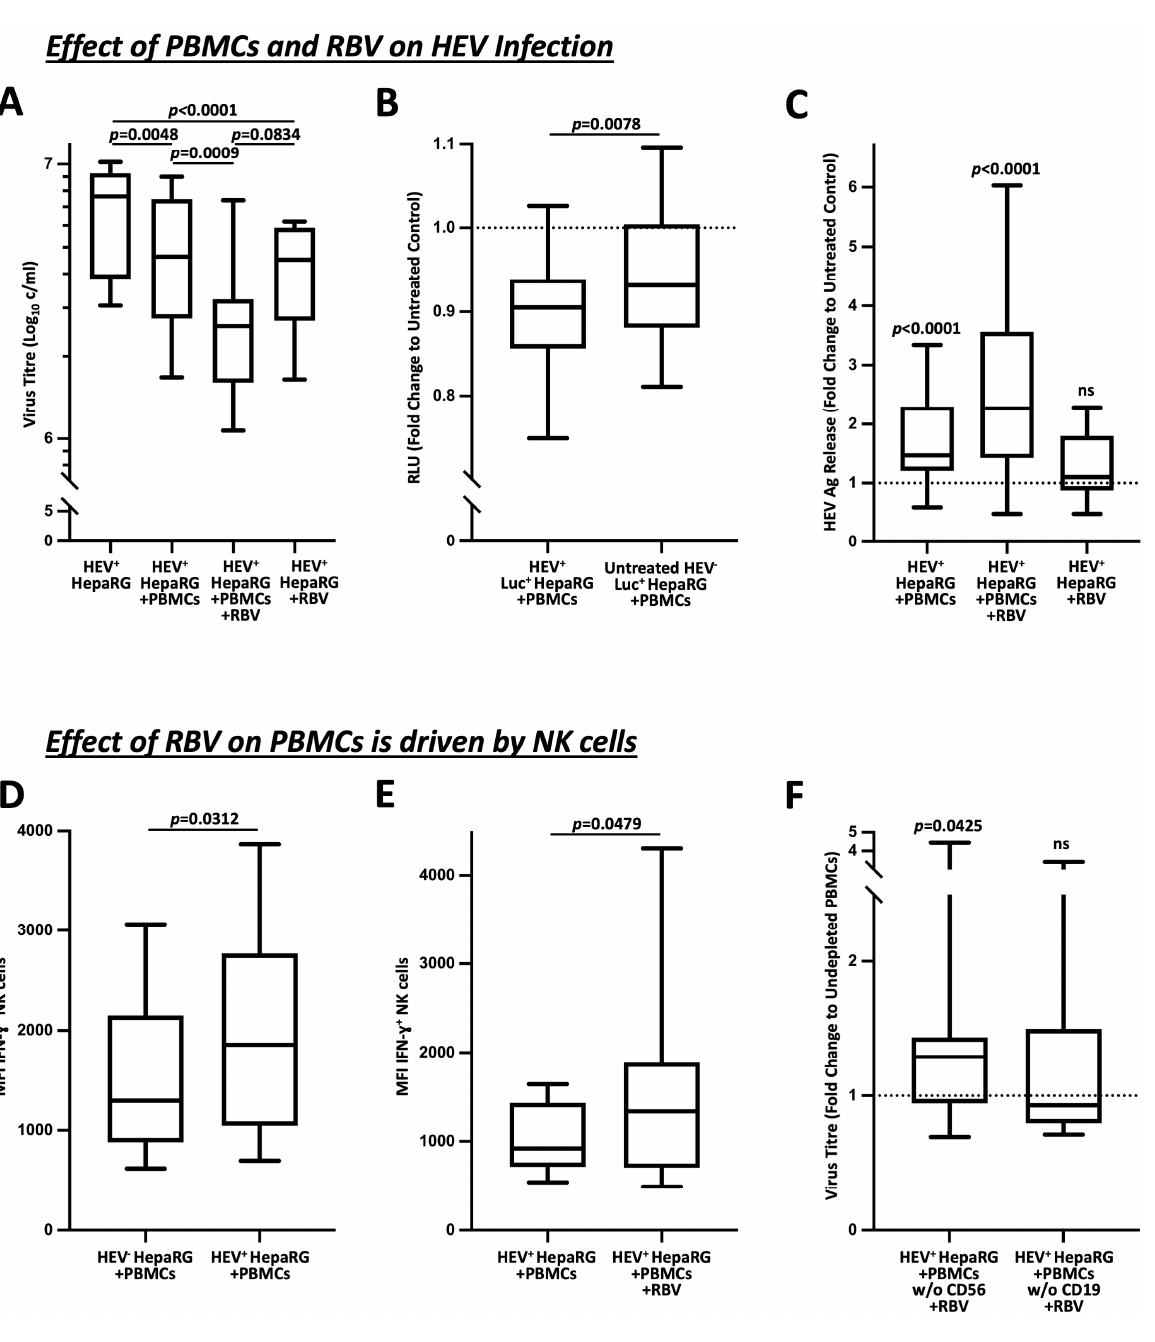
Figure 1. Immunomodulation of RBV boosts the antiviral effect of NK cells. ( A ) demonstrates the effect of RBV on PBMCs in HEV + HepaRG co-culture represented by alteration in viral loads (n = 24). ( B ) shows the change of luciferase activity as indication for HepaRG viability in sole presence of PBMCs. The corresponding setups without co-culture of PBMCs acted as the untreated controls (n = 39). ( C ) pictures the quantification of HEV antigen concentrations from co-culture supernatants in relation to untreated controls (n = 24). ( D , E ) show the effects of co-culture of PBMCs with infected target cells and RBV treatment on IFN- γ production by NK cells upon IL-12/IL-15 stimulation (n = 6 and n = 13). ( F ) illustrates the effect of CD56 depletion on antiviral activity by PBMCs in the context of RBV treatment (n = 26). Appearance: median with interquartile range (whiskers min to max), statistical analysis: Friedman test with Dunn’s multiple comparisons test ( A ), Wilcoxon matched-pairs signed-rank test ( B , D , E ) or one-sample Wilcoxon signed-rank test ( C , D